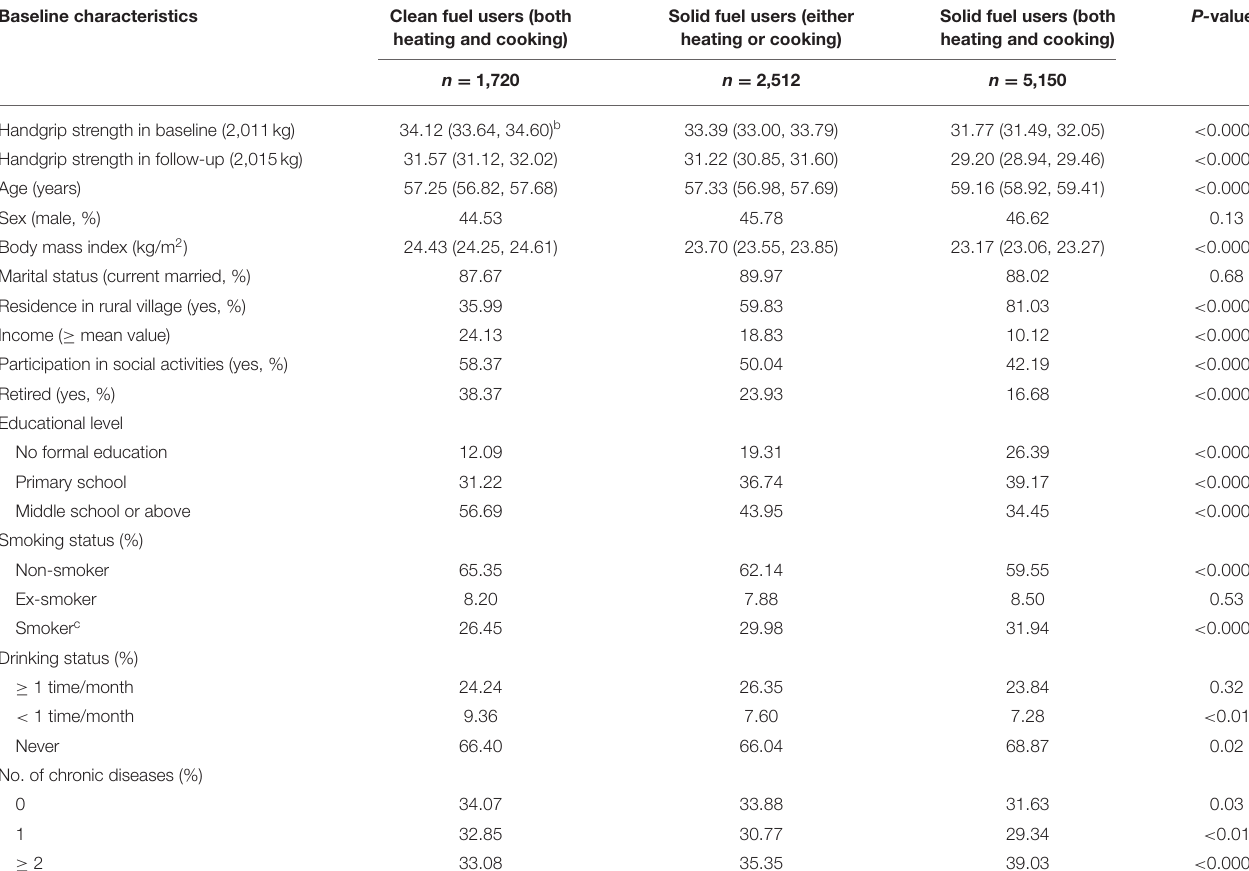
TABLE 1 | Baseline participant characteristics according to fuel users. Baseline characteristics Clean fuel users (both